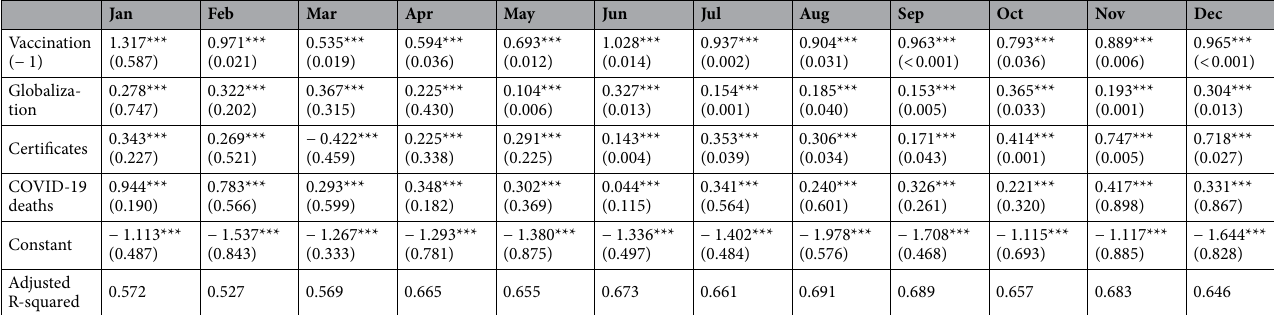
Table 4. Robustness check relationship between COVID-19 vaccination and globalization (coefficient and probability two-stage least squares (2SLS) regressions). Probabilities are in parentheses. ***Statistical significance at the